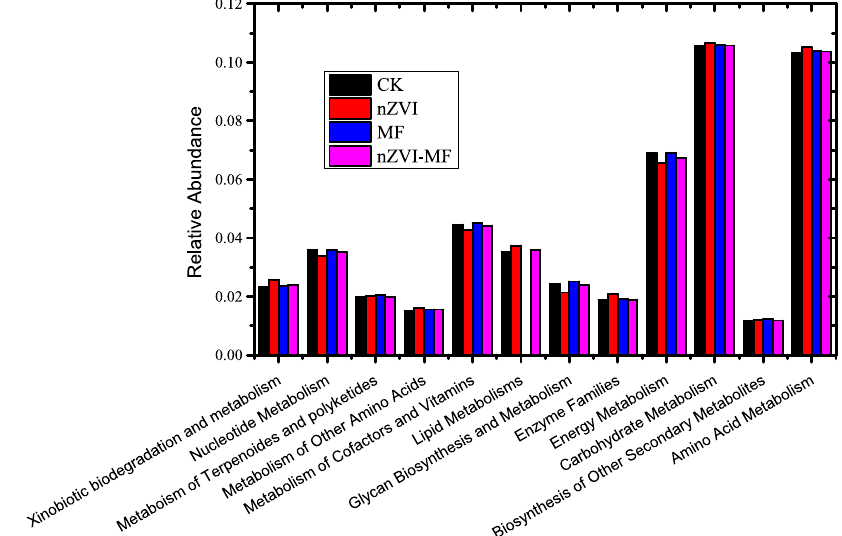
Fig. 7 The prediction of community functions based on KEGG analysis. The x -axis showed the second level metabolic functional genes and the y -axis showed the relative abundance of each functional gene.